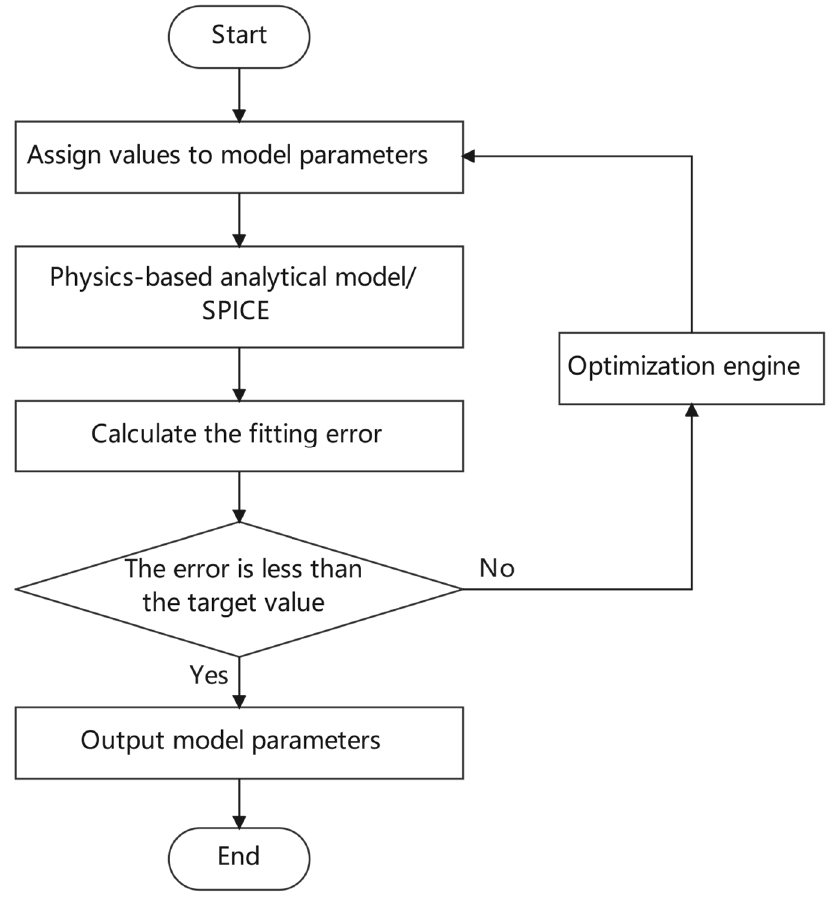
Figure 1. The process of model parameter extraction.